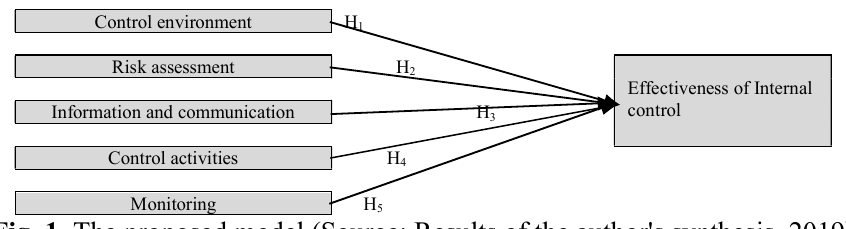
Fig. 1. The proposed model (Source: Results of the author's synthesis,